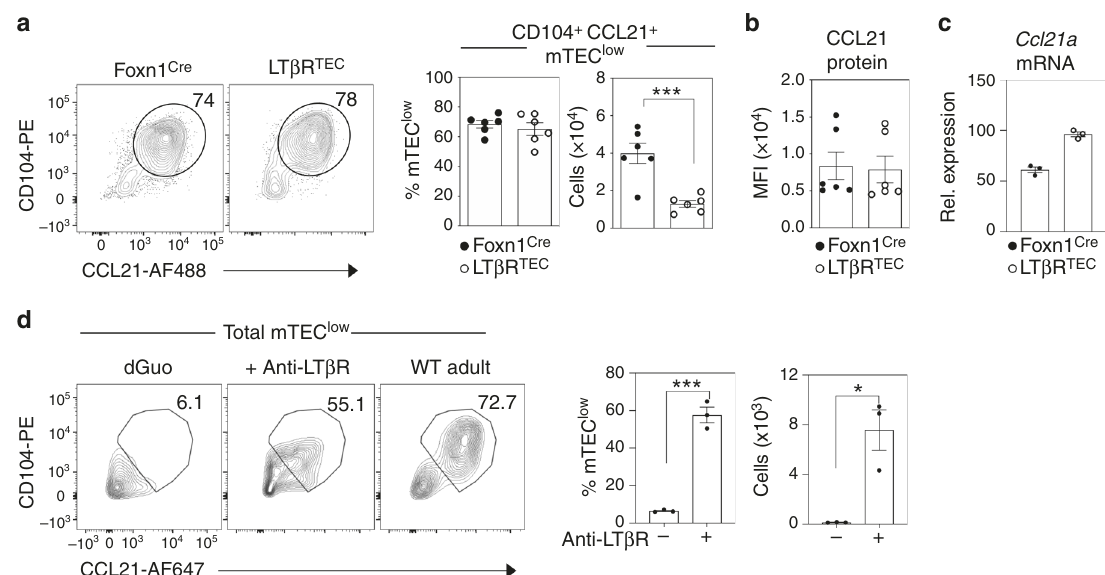
Fig. 3 Impaired production Of CD104 + CCL21 + mTEC low In LT β R TEC mice. a mTEC low from Foxn1 Cre and LT β R TEC mice, analysed for surface expression of CD104 and intracellular expression of CCL21. Bar graphs show cell percentages and absolute cell numbers in Foxn1 Cre ( n = 6 biologically independent samples, closed symbols) and LT β R TEC mice ( n = 6 biologically independent samples, open symbols), over three independent experiments. Signi fi cant P values using two-tailed unpaired t test are as follows: no. of cells P = 0.0009. b MFI levels of intracellular CCL21 expression in pre-gated CD104 + CCL21 + mTEC low from Foxn1 Cre (closed symbols) and LT β R TEC (open symbols) mice, n = 6 biologically independent samples, over three independent experiments. c Levels of Ccl21 mRNA in FACS sorted CD104 + mTEC low from Foxn1 Cre (closed symbols) and LT β R TEC mice (open symbols), data representative of three biological sorts. d Alymphoid 2dGuo-treated FTOC cultured for 4 days in the presence or absence of agonistic anti-LT β R (2 μ g/ml) were pooled and analysed by fl ow cytometry for the expression of CCL21 and CD104. Freshly isolated adult WT mTEC low were stained alongside for comparison. Signi fi cant P values using two-tailed unpaired t test are as follows: % cells P = 0.0003, no. of cells P = 0.0102. Six FTOC cultured lobes were pooled per data point, n = 3 biologically independent samples, over three independent experiments. All data are represented as mean ± SEM. * P < 0.05 and *** P < 0.001. Source data are provided as a Source Data fi